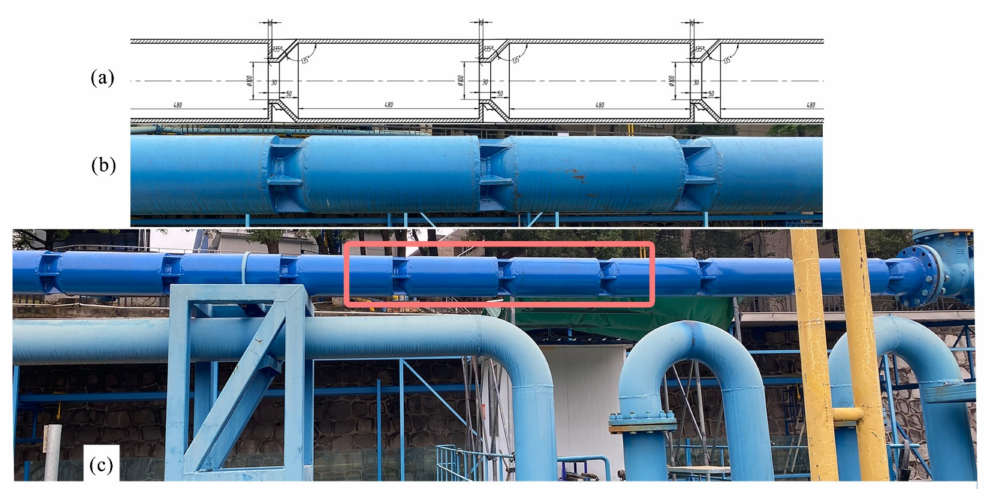
Figure 7. Multi-stage taper reducer in the pipeline; ( a ) CAD layout; ( b ) Manufactured product; ( c ) Installation layout in the